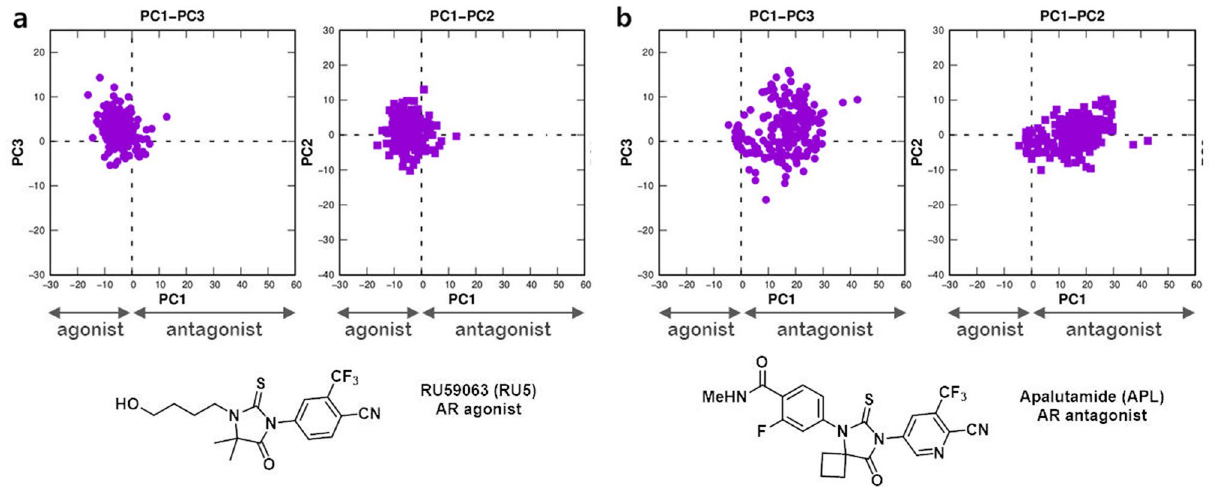
Figure 11. Projection of aMD trajectories of the wild type ARs bound to ( a ) RU5 and ( b ) APL in conformation 2 . Images were created by using Gnuplot v5.2 57 and